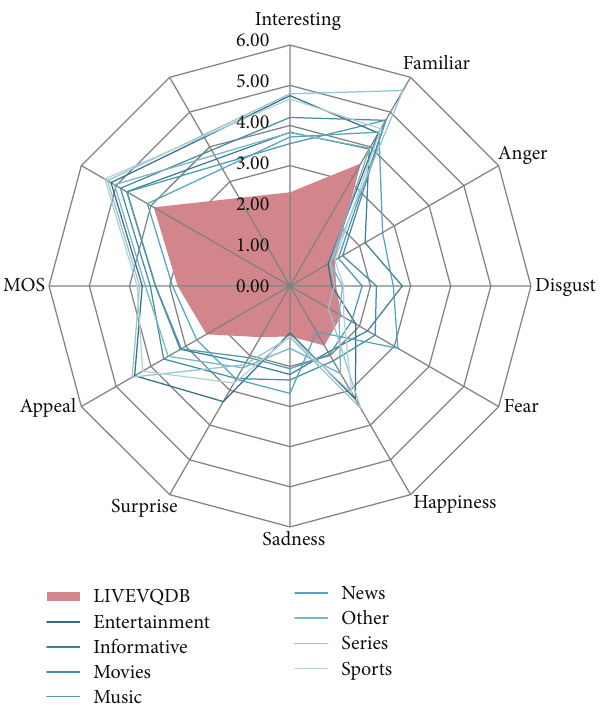
Figure 1: Average scores for different variables (grouped by video